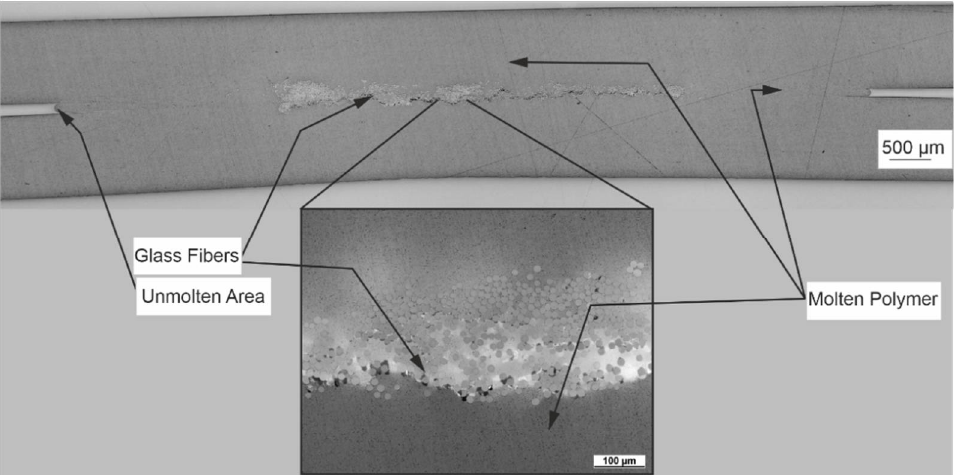
Figure 6. Overview and detailed image of single glass fiber roving and two 1000 m polymer films after consolidation.